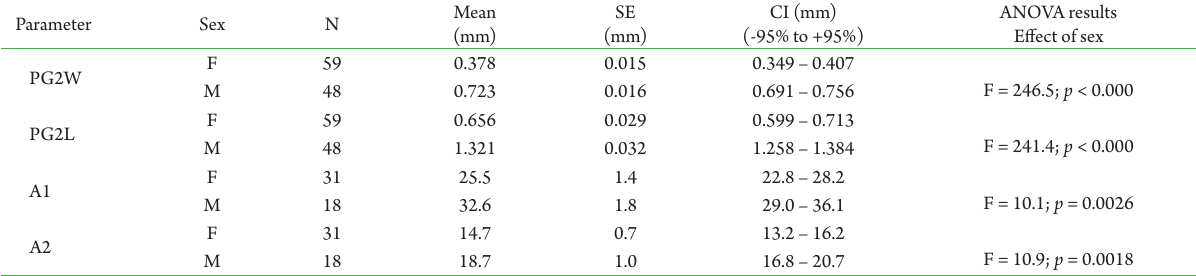
Table 3. Means, standard error (SE) and confidence limits of the morphological parameters studied in mature specimens of Quadrivisio lutzi , considering mature those females with sizes over 3 mm BL and those males over 5 mm BL. The effect of sex was evaluated for each parameter by a one-way ANOVA, confirming sexual dimorphism in mature amphipods for all parameters studied.